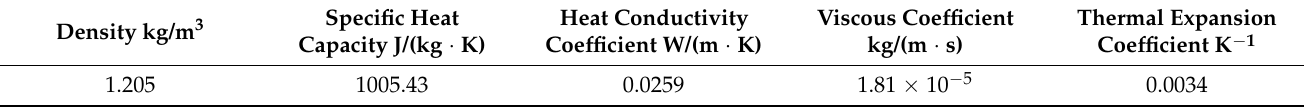
Table 3. The physical parameters of